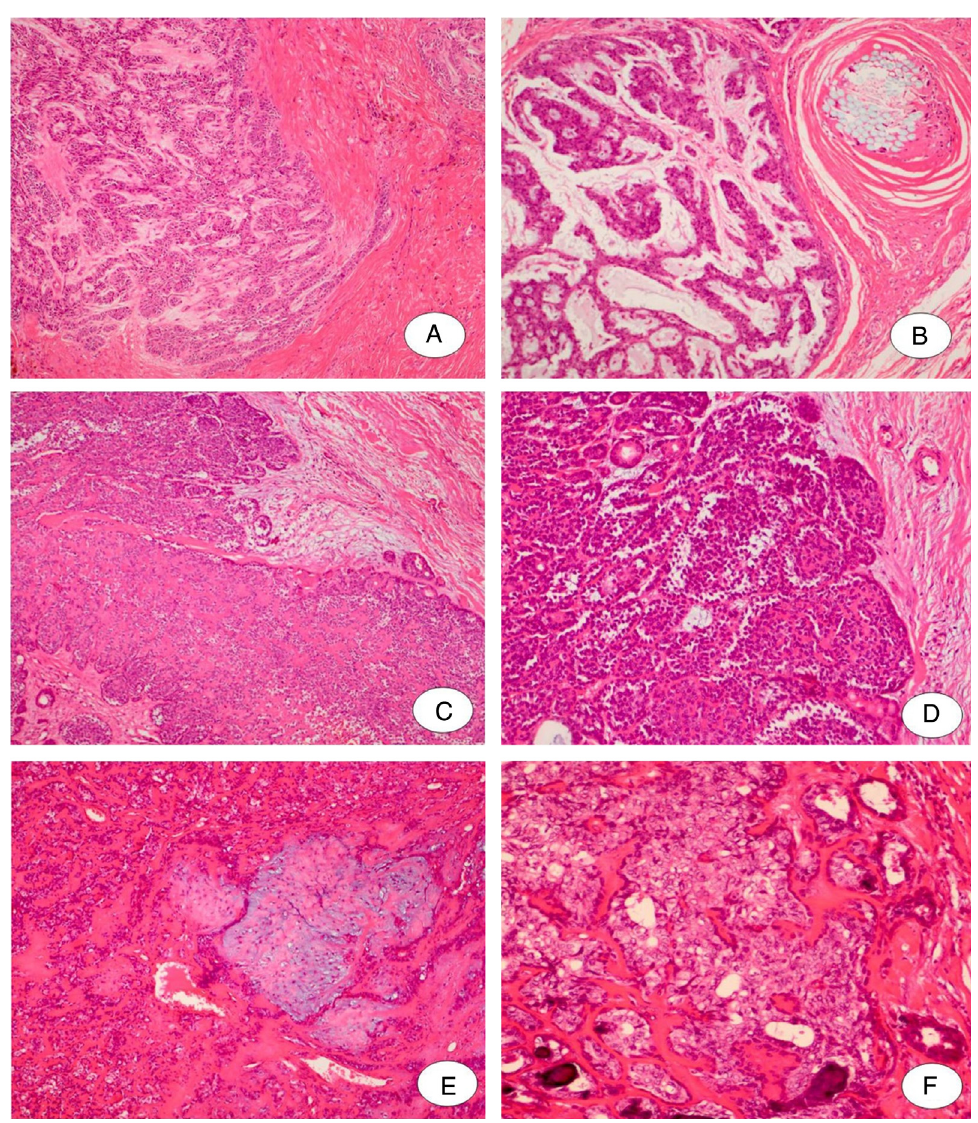
Frankly invasive myoepithelial carcinoma: (A) Island of myoepithelial cells infiltrating the tissue (H&E × 10); (B) cords of pleomorphic myoepithelial cells surrounded by myxoid stroma. Note the reaction against thread suture from previous surgery in the top right side of the image (H&E 20 × ). Frankly invasive epithelial-myoepithelial carcinoma: (C) Proliferation of epithelial and myoepithelial cells in a nodular growth (H&E 10 × ); (D) Small lumen bounded by eosinophilic, cuboidal, intercalated duct-like cells. These cells are surrounded by small and non-staining cytoplasm cells. Note the maintenance of basal cells in the periphery of nest cells surrounded by fibrous septa (H&E 20 × ). Minimally invasive epithelial-myoepithelial carcinoma: (E) Epithelial-myoepithelial proliferation arising in pleomorphic adenoma residual (H&E 10 × ); (F) eosinophilic, hyalinized basal lamina material surrounds